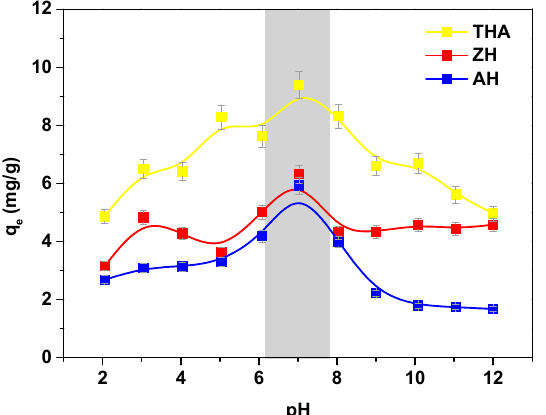
Figure 1. Effect of dosage of hydrogel on the sorption capacity for the Mn(II) complexes with EDDS on AH, ZH and THA (initial concentration 1 × 10 − 3 M).